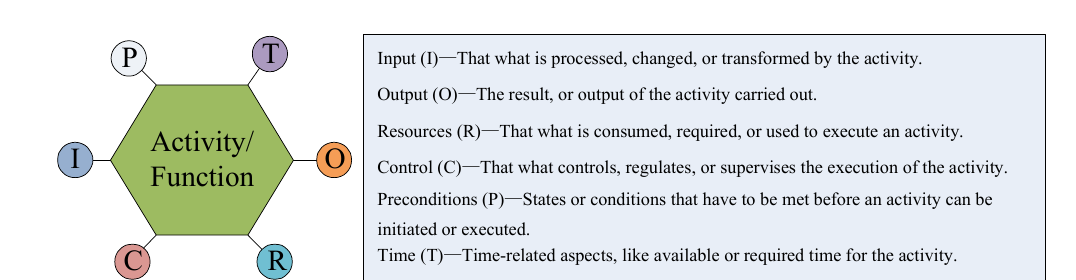
Figure 3. The six parameters of FRAM.